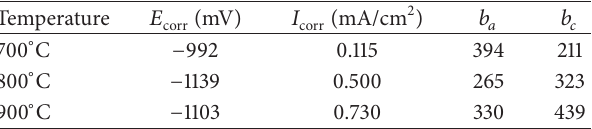
Table 1: Electrochemical parameters of potentiodynamic polariza- tion